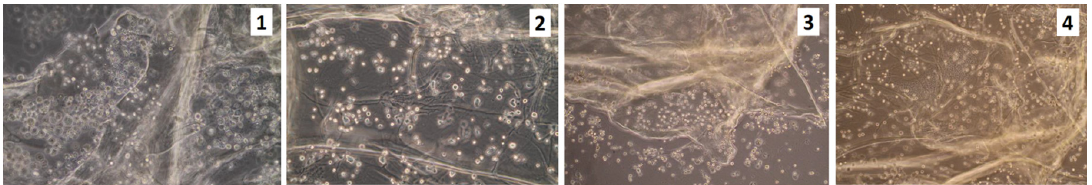
Figure 15. VK2/E6E7 cells on the edges of the scaffolds (sample 1—chitosan crosslinked with adipic and malonic acid; sample 2—chitosan crosslinked with adipic and L -glutamic acid; sample 3— chitosan crosslinked with adipic, L -glutamic and malonic acid; sample 4—chitosan crosslinked with adipic and levulinic). Figure 16. Cells seeded on the scaffolds and then transferred after few hours to a new hole containing fresh culture medium (sample 1—chitosan crosslinked with adipic and malonic acid; sample 2— chitosan crosslinked with adipic and L -glutamic acid; sample 3—chitosan crosslinked with adipic, L - glutamic and malonic acid; sample 4—chitosan crosslinked with adipic and levulinic).